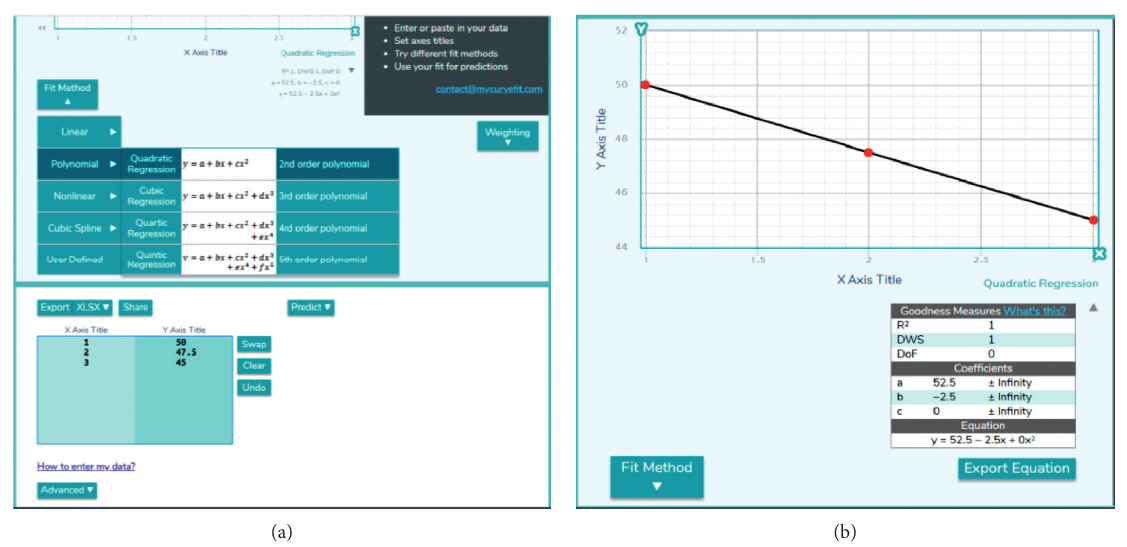
Figure 2: The data entry and the output screens of the MyCurveFit